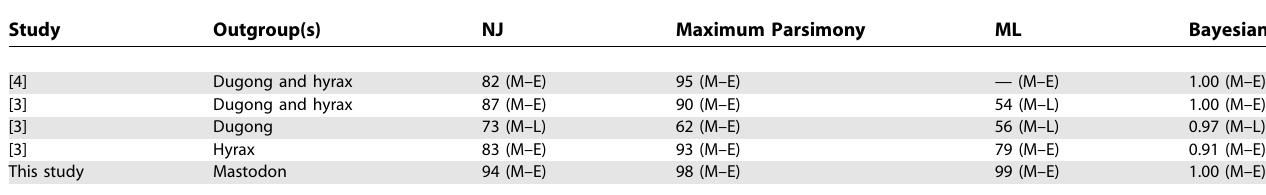
Table 1. Increase of the Support (Bootstrap or Posterior Probability) When Using the Mastodon as Outgroup to Reconstruct the